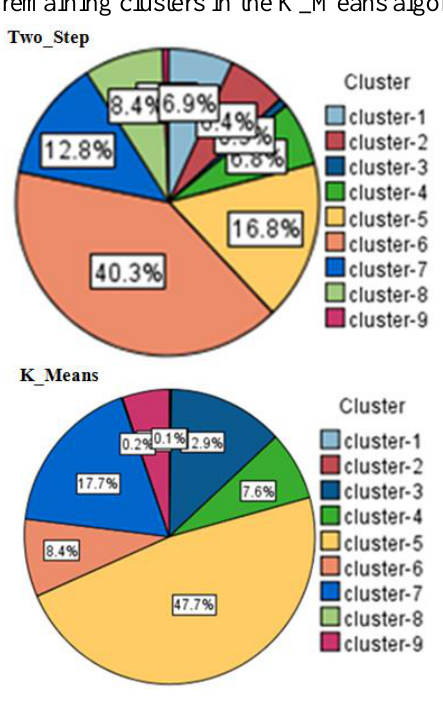
Figure 9: Two_Step and K_Means with 9 clusters.